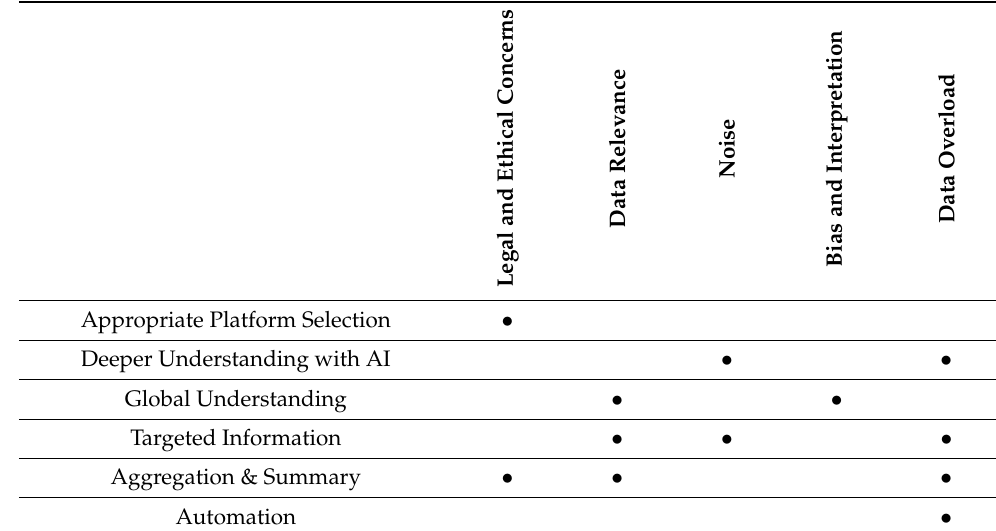
Figure 2. Conceptual diagram of deep learning-based, countrywide cyber index implementation. Table 3. Mapping between requirements and